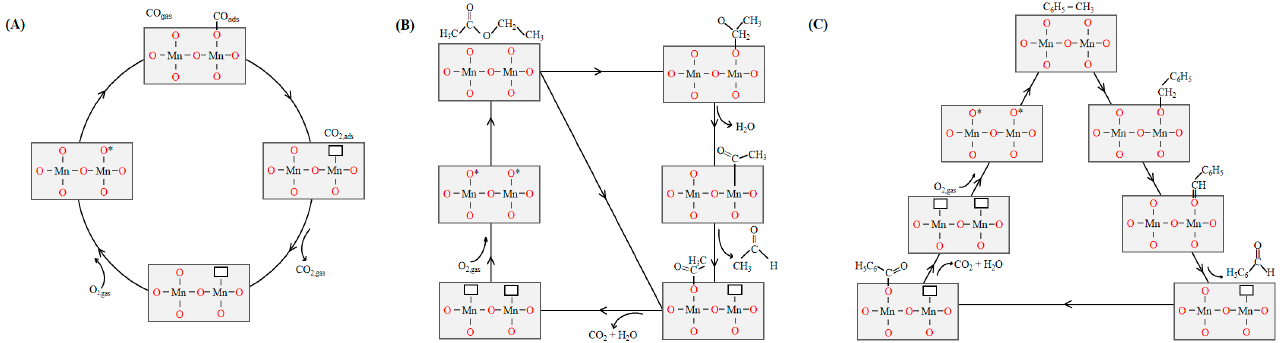
Figure 11. Proposed catalytic mechanisms of ( A ) CO, ( B ) ethyl acetate, and ( C ) toluene oxidation over the 15Cu/OMS-2 sample.